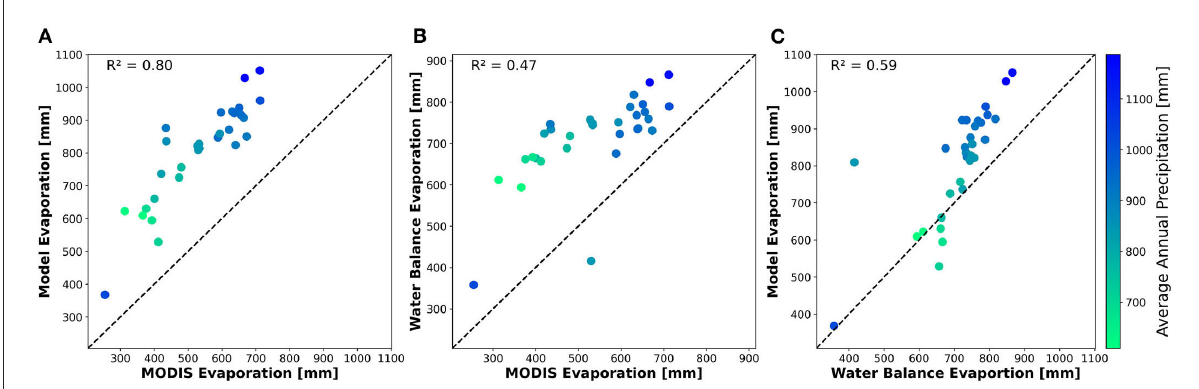
FIGURE12 Scatter plots of V4-LD-FX version (A) Noah-MP evaporation vs. MODIS, (B) estimated evaporation from water budget vs. MODIS, and (C) estimated evaporation from water budget vs. model for 31 selected basins using an 11-year averaged. The color bar indicates the 11-year average precipitation (mm) over selected basins within the domain from higher (blue) to lower (green) values.